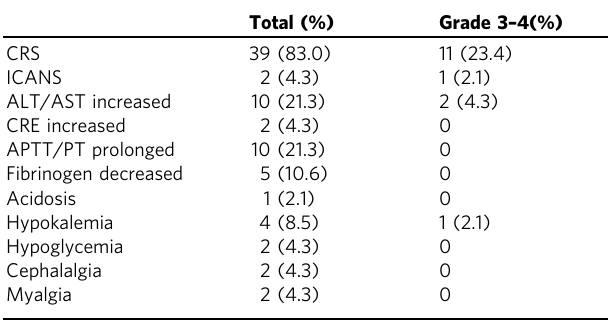
Table 3 Non-hematological adverse events within 4 weeks a